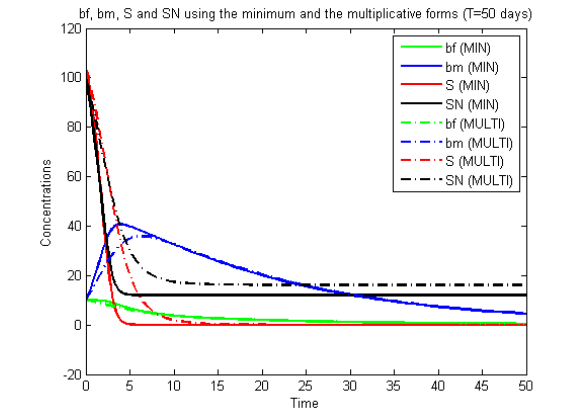
Figure 10. Concentrations of the ODE model using the minimum and the multiplicative formulas (T = 50